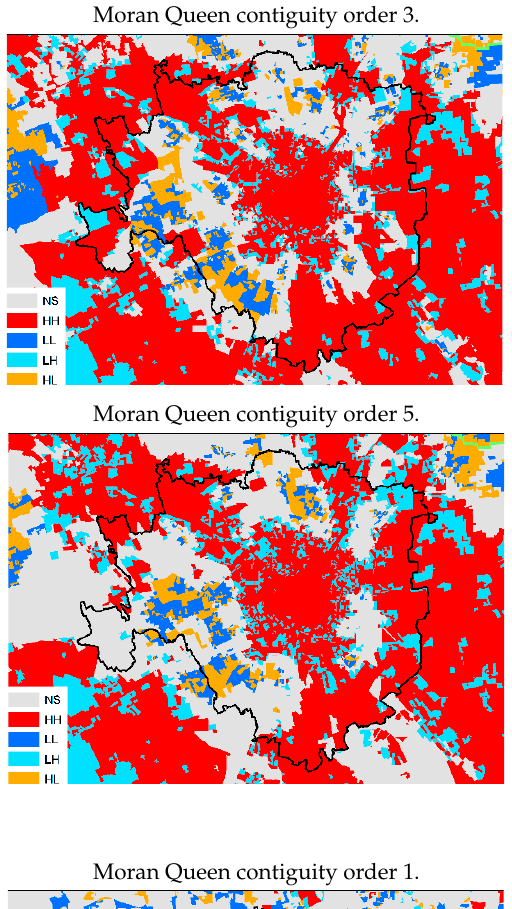
Moran Queen contiguity order 2. Moran Queen contiguity order 3.